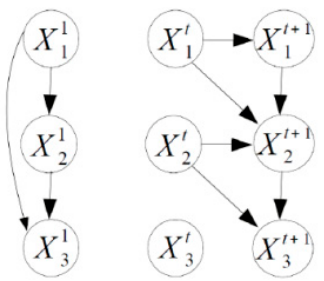
Figure 3. Example of a DBN structure. Prior BN (left) and transition BN (right) for three variables.